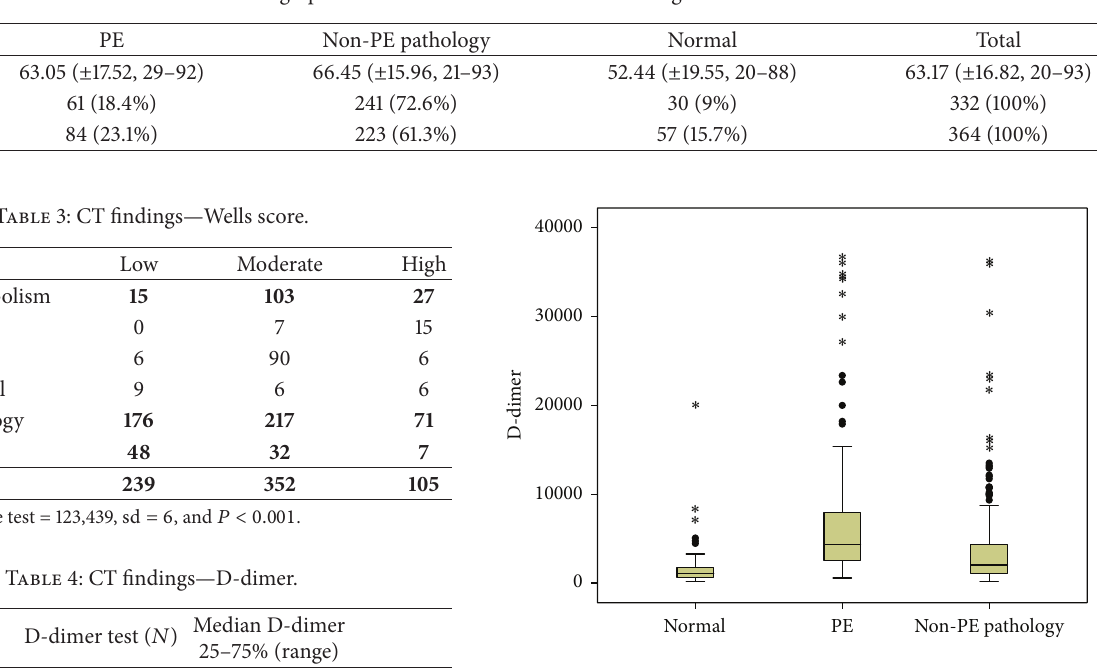
Table 2: Demographic and clinical characteristics according to CT results.